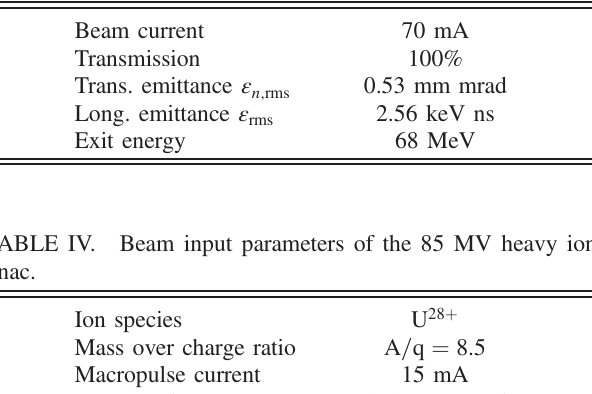
FIG. 22. Longitudinal beam envelopes along the 65 MV proton DTL, with envelopes centered around the bunch center particle.